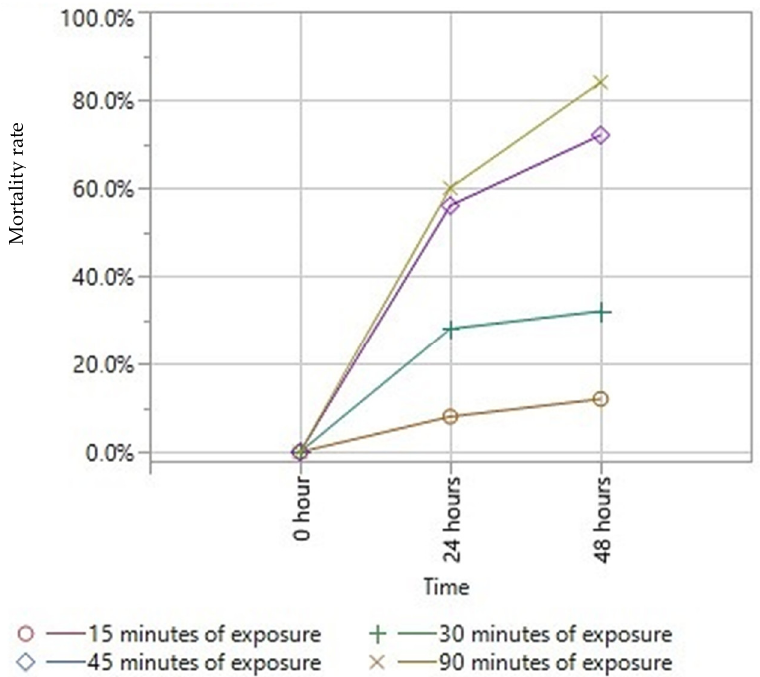
Figure 3. Mortality rates obtained with fumigation tests at 24 and 48 h. Table 3. Mean and SD (±) percent of V. destructor mites that were examined and found dead at 48 h, after each interval of exposure to oregano O. heracleoticum essential oil (EO) vapors.